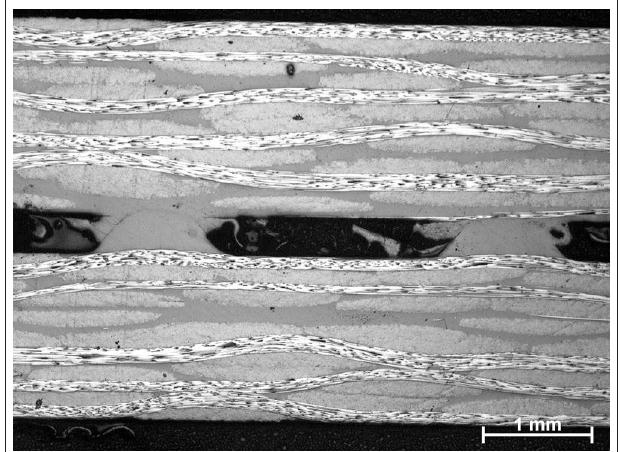
FIGURE 1 | Lap shear strength (LSS), welding energy and vibration (Us) time for CF/PPS single-lap coupons welded with flat and triangular energy directors (Villegas et al., 2015; Villegas and Palardy, 2017).